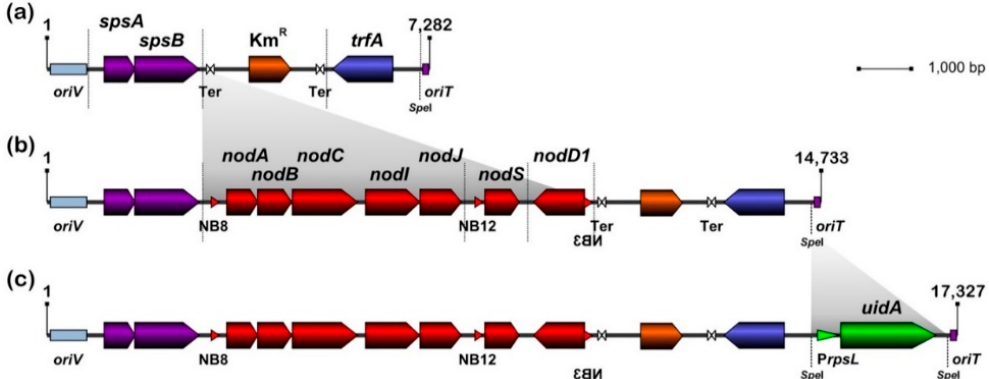
Figure 1. Genetic maps of pMiniSym1, pMiniSym2 and pMiniSym2-Gus. In the linear genetic maps of pMiniSym1 ( a ), pMiniSym2 ( b ) and pMiniSym2-Gus ( c ), each of the assembled genetic modules is delimited by vertical dashed lines. pMiniSym1 carries functions for propagation (TrfA, oriV ), selection (Km R Omega interposon) and maintenance ( spsAB ) in E. coli and rhizobia, as well as a conjugative origin of transfer ( oriT ). In addition to pMiniSym1 functions, pMiniSym2 includes a small set of nodulation genes that confers to recipient bacteria, perception of plant flavonoids by NodD1, synthesis of pentameric methylated nodulation factor (NF) (by NodA, NodB, NodC and NodS) and their secretion (by NodI and NodJ), via a NodD1-dependent transcriptional activation mediated by the NB8 and NB12 nod boxes. pMiniSym2-Gus carries the uidA reporter gene for β -glucuronidase (Gus), which constitutive expression is controlled by the rpsL promoter (P rpsL ) of NGR234 [59].